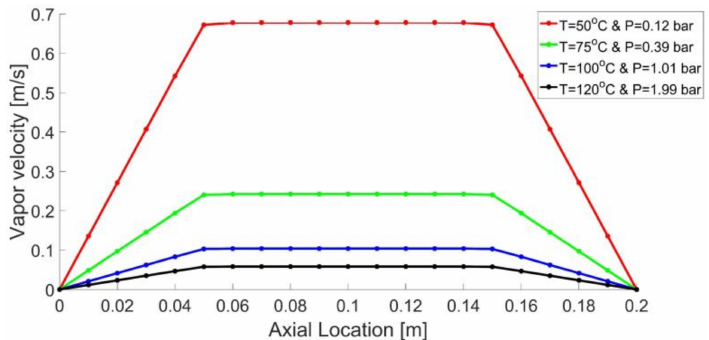
Figure 5. Vapor velocity along the heat pipe at different operating